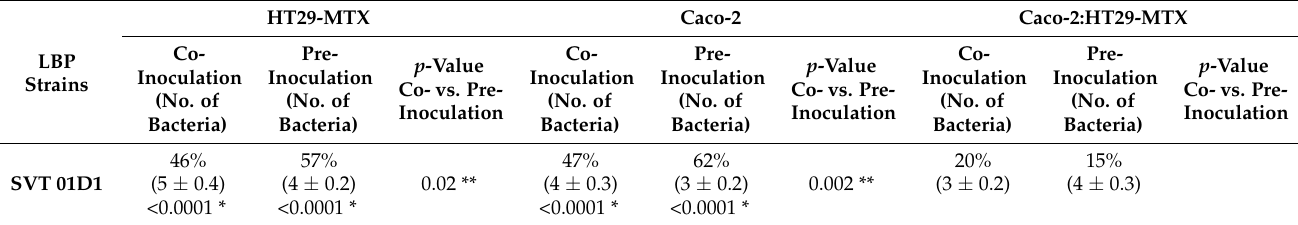
Table 1. The percentage of reduction in adhesion to the cell lines by AIEC and the number of AIEC cells adhering per cell (Mean ± SEM) in the presence of LBP strains (shown in bold letters) in both co-inoculation and pre-inoculation experiments. * Shows significance of reduction in the number of Table 1. Overall, pre-inoculation resulted in a greater reduction in adhesion of AIEC AIEC adhering per cell in the presence of the LBP strain versus the number of AIEC alone. ** Shows significance of reduction in the number of AIEC adhering per cell in pre-inoculation experiments versus co-inoculation. p -values that are only significant have been